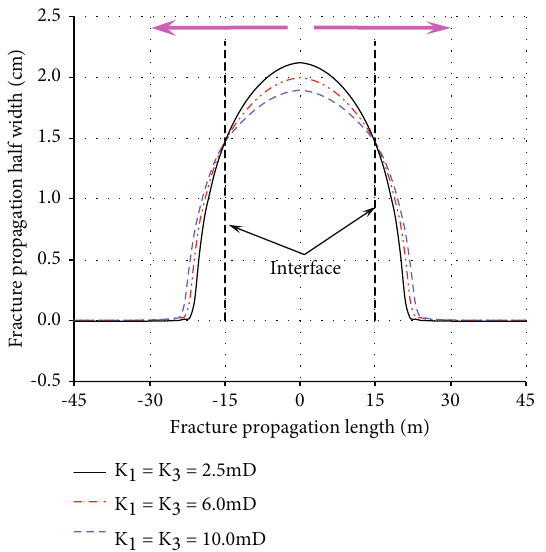
Figure 16: Fracture propagation geometry in lower-medium- higher formation permeability layer